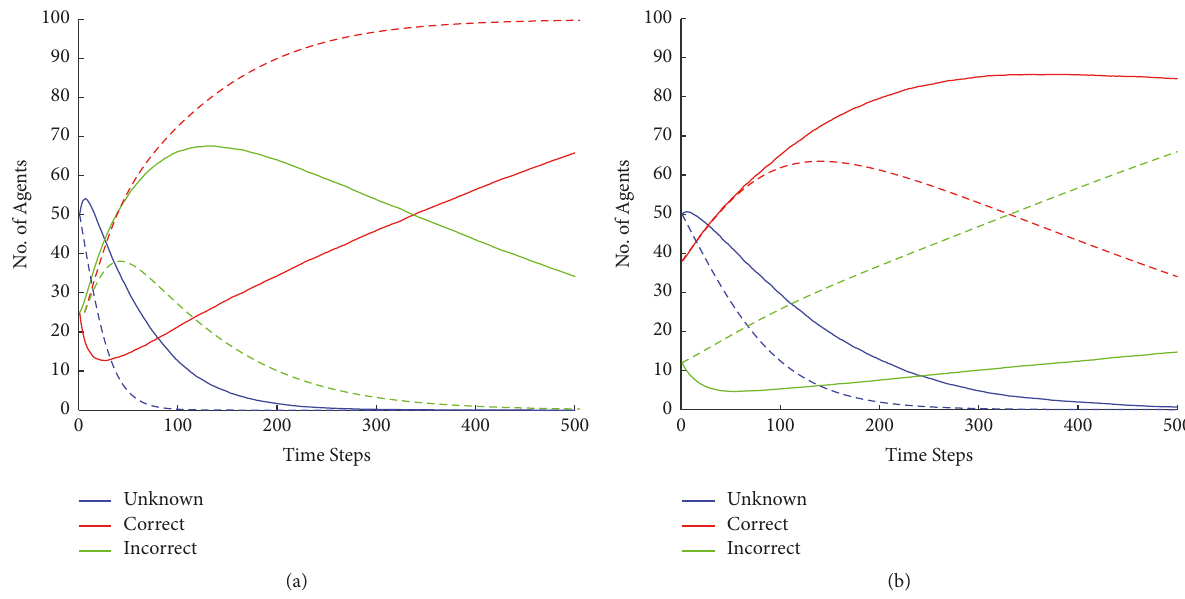
Figure6:Resultsagainstbothscenarioswhereunknownpopulationhaslowtrustinthecommunity.(a)LHLcaseagainst“nominalscenario”; (b) LLH case against “wishful-thinking